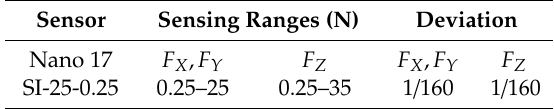
Table 2. The measurement ranges and deviation of the force sensor used in the experiment. Sensor